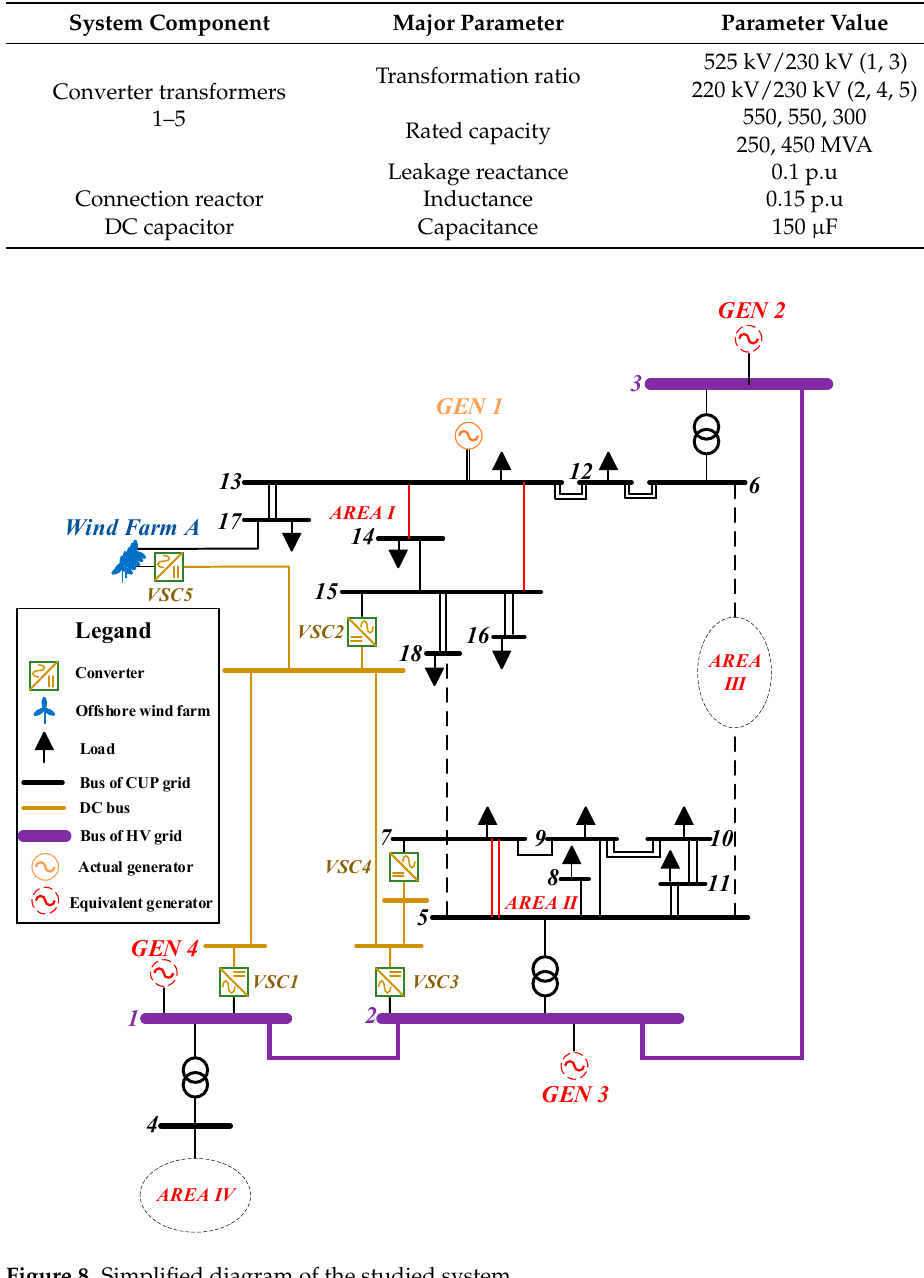
Figure 8. Simplified diagram of the studied system.